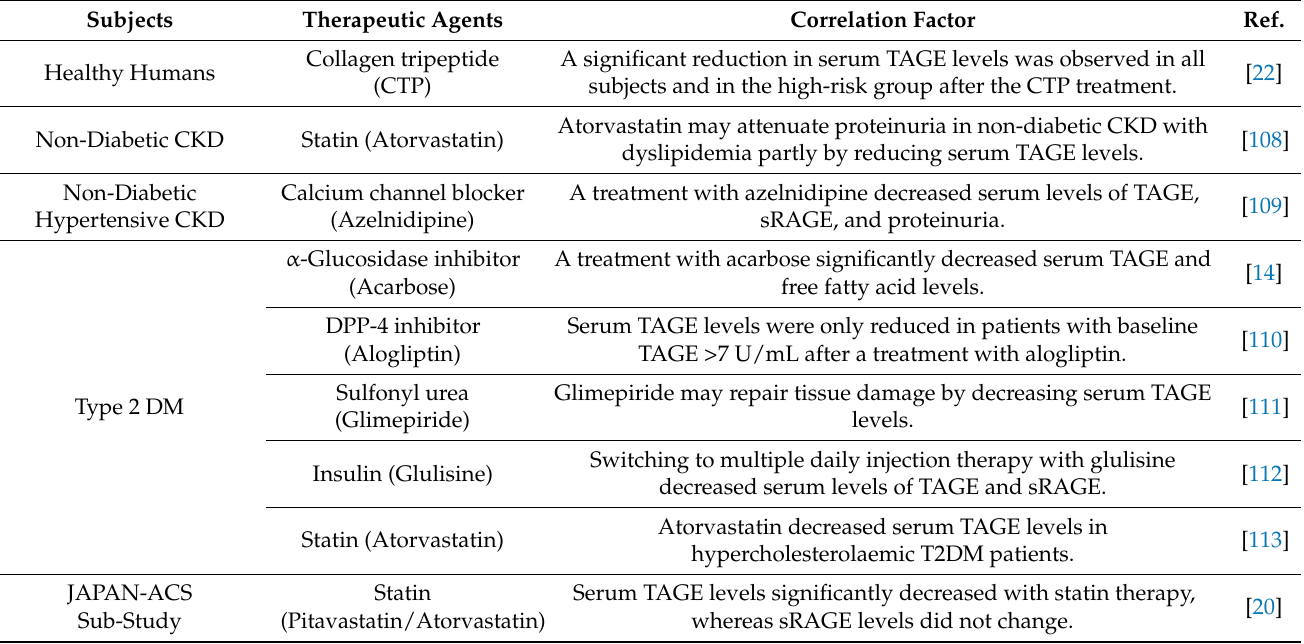
Table 2. Changes in circulating TAGE levels with